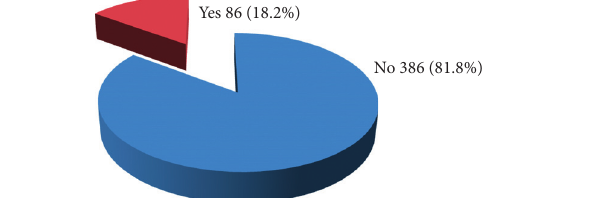
Figure 1: Magnitude of UTI among adult patients attending the OPD in Tigray region hospitals, Ethiopia,